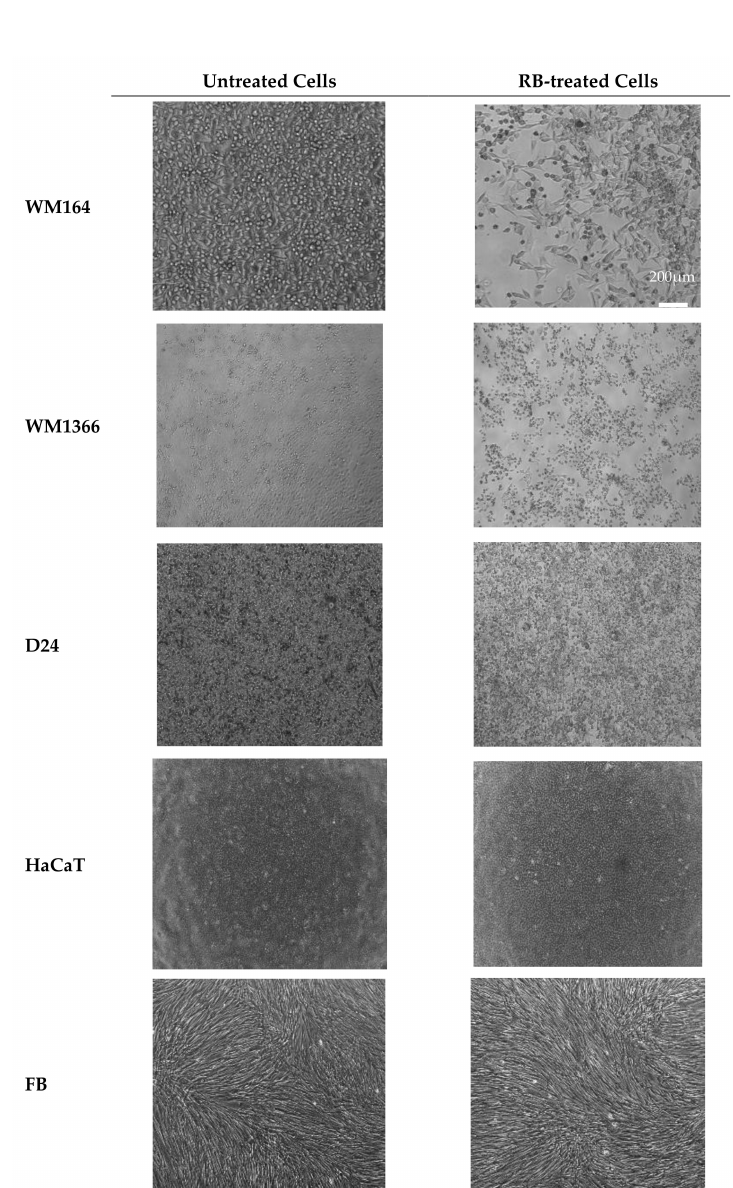
Figure 3. Light microscopy images of the cells. Untreated cell lines in culture and RB-treated cells after 48 h treatment with an IC 50 concentration of RB. Bright field images are viewed under low power (4 × objective). Treated melanoma cells (WM164, WM1366, and D24) appeared rounded, shrunken, and damaged. Many of the dead cells were detached from the plate and floating in the media. HaCaT cells only showed some morphological changes but remained attached to the surface and Fibroblast cells remained intact. Scale bar = 200 µ